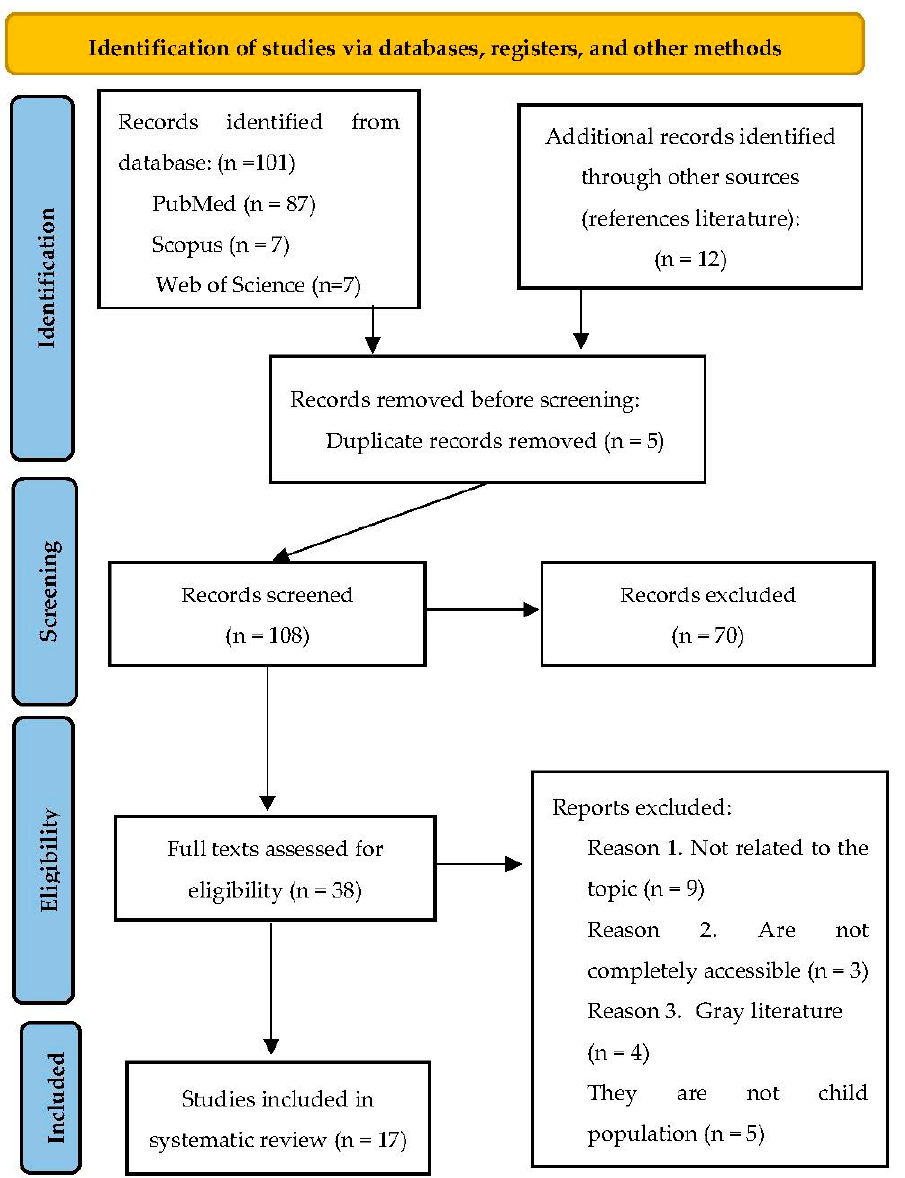
Figure 1. Flow diagram of the articles during the selection process.